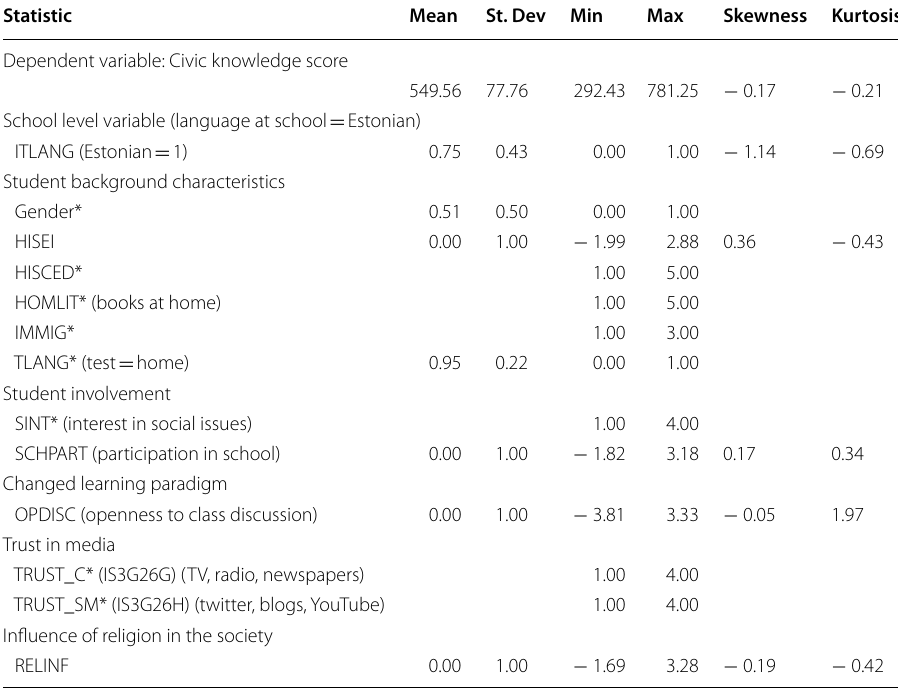
All variables have 2857 observations, *indicates categorical variables